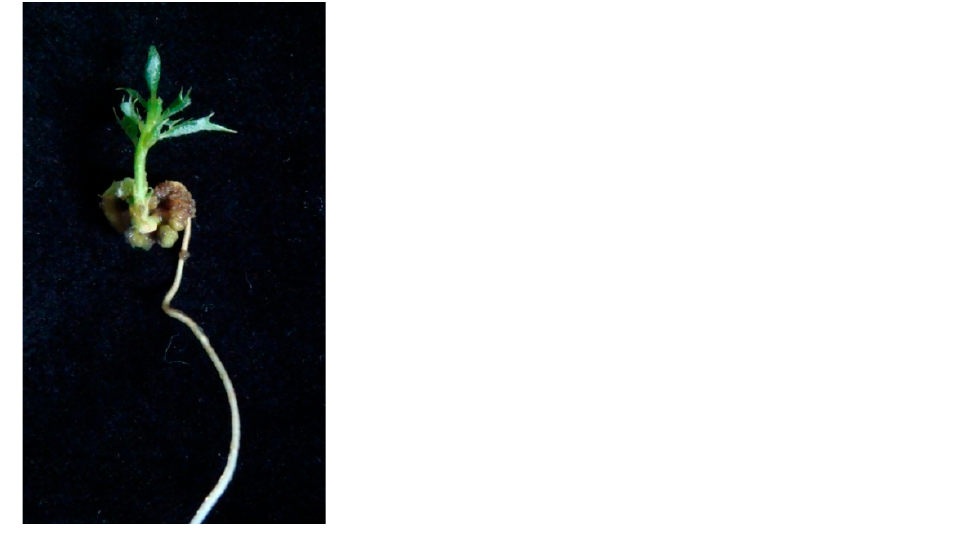
Figure 3. Somatic plant regenerated from embryogenic cultures of line Q8 after 15 min in PVS2, cryopreserved for one year and cultured for 8 weeks on germination medium.